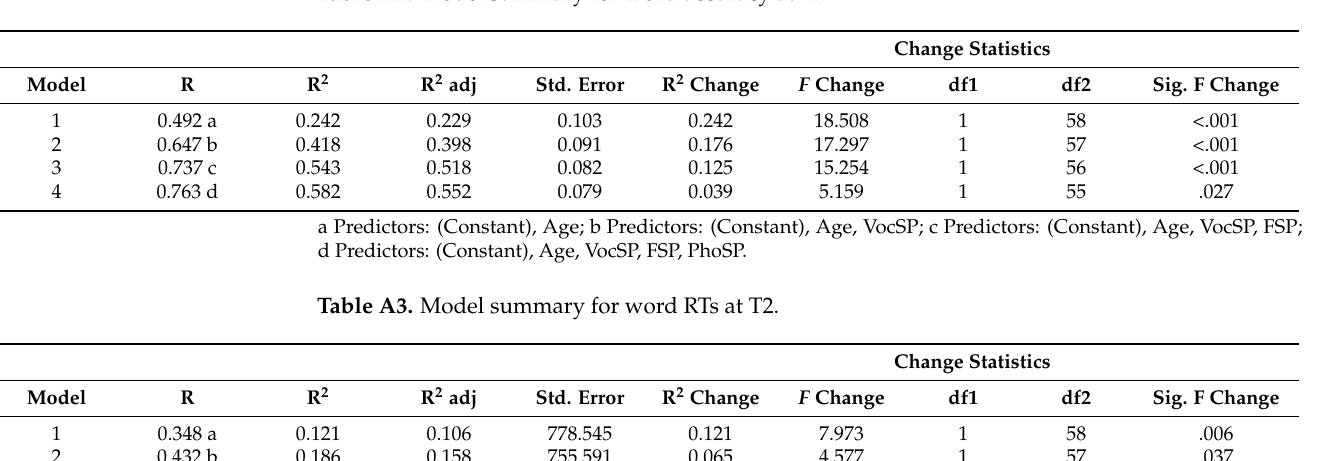
Table A2. Model summary for word accuracy at T2.